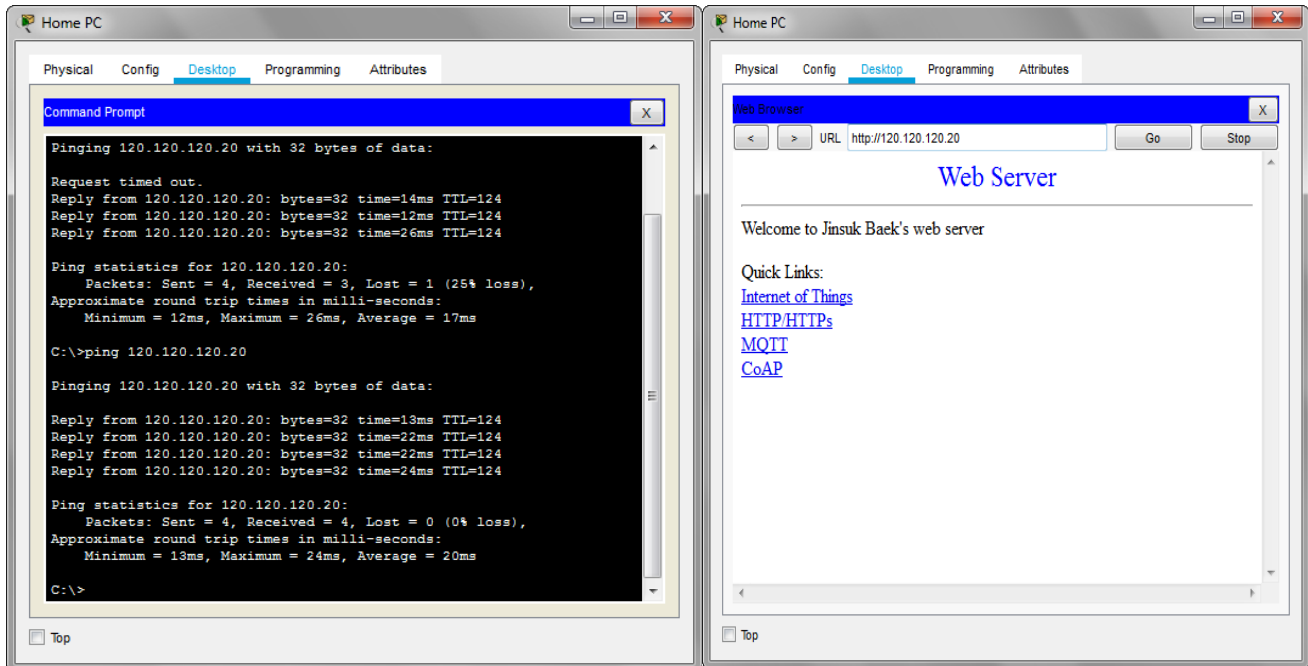
Figure 8. Access to the external network from host on the inside-subnet.